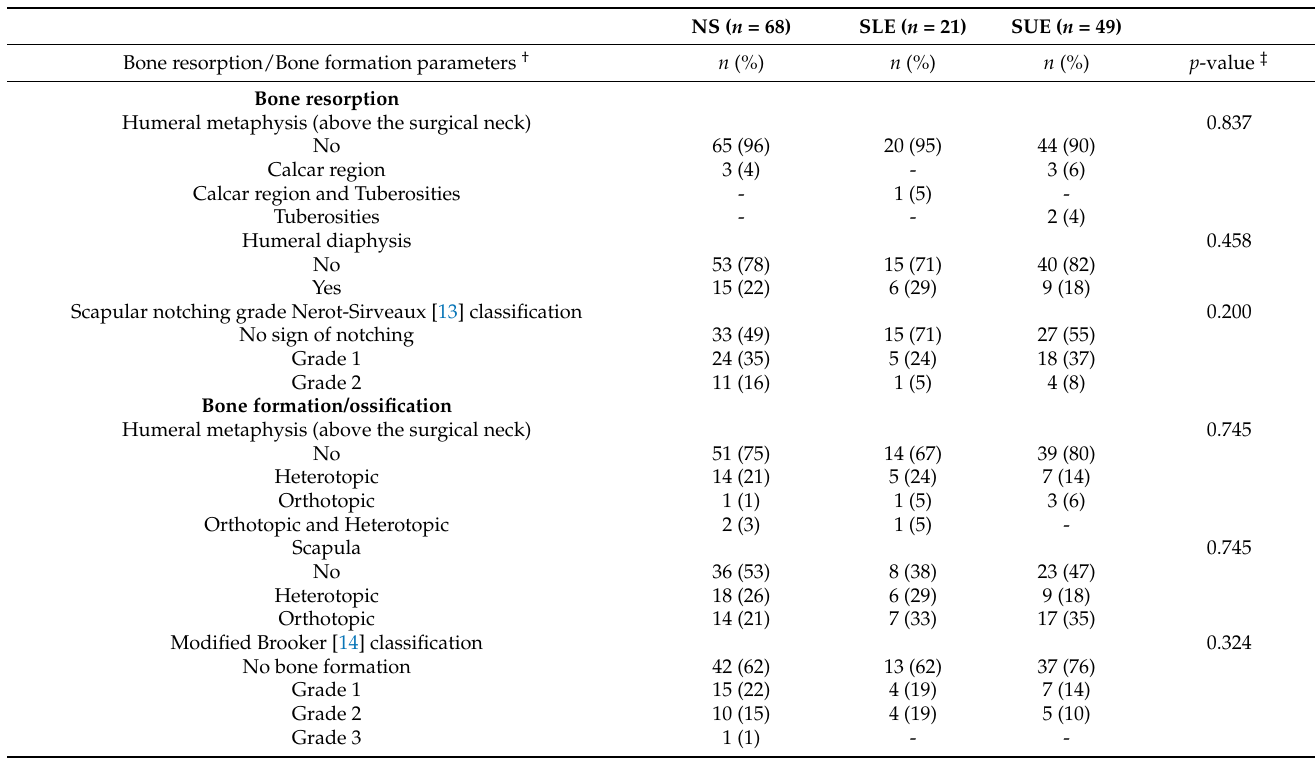
Table 4. Radiological observation of bone resorption and bone formation 5 years after RSA